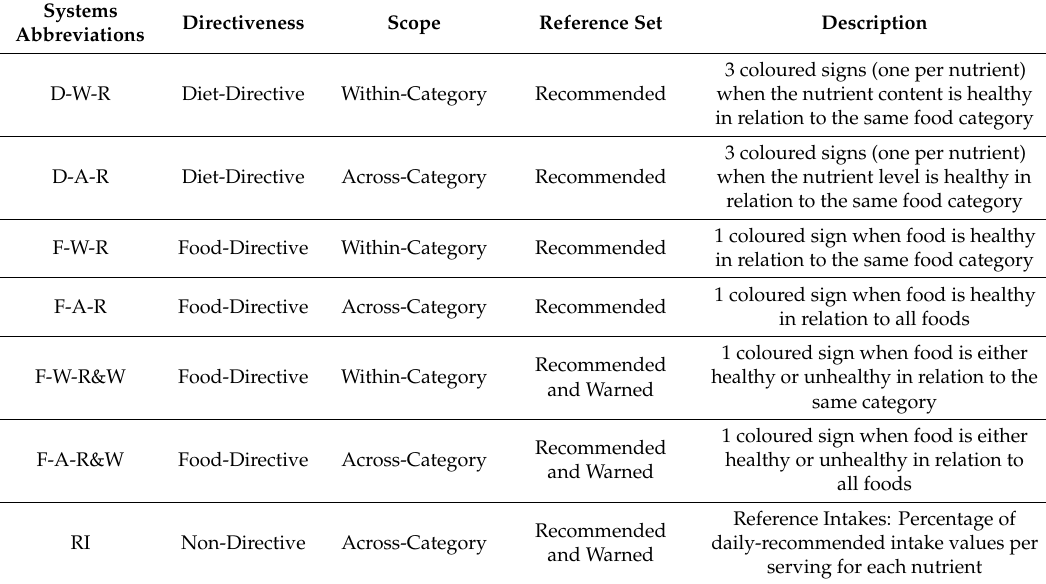
Table 5. The seven tested systems according to their key